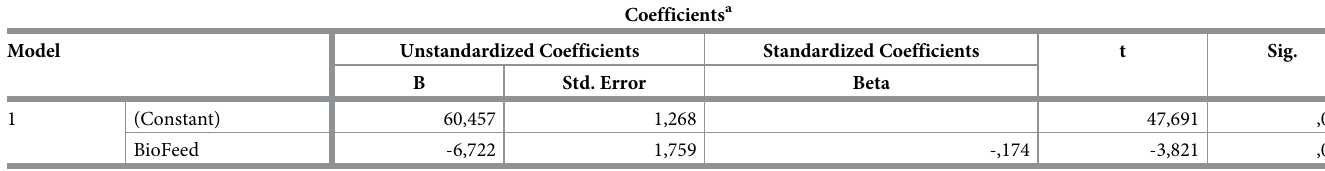
Table 3. Linear regression between biofeedback and test